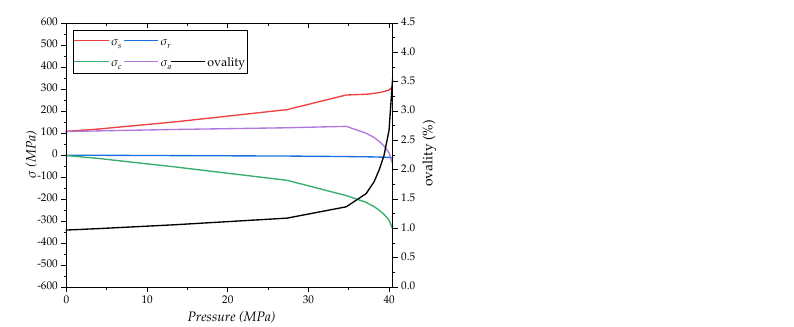
Figure 15. Stress changing history at integration point A (T → P loading path).